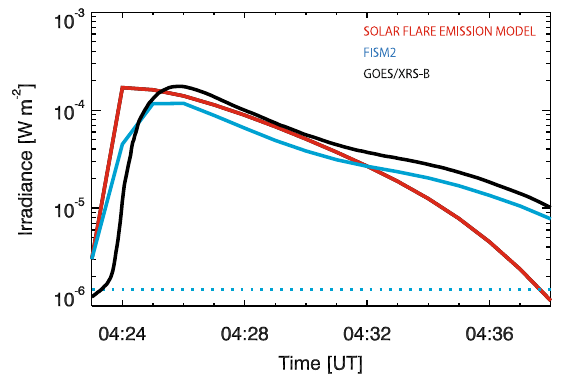
Fig. 1 Example of the observed and modeled soft X-ray fluxes of GOES/XRS-B. The soft X-ray fluxes of GOES/XRS-B during the X1.1-class flare on November 8, 2013. The solid red, blue, and black lines indicate the light curves obtained from the SFEM, the flare component of FISM2 (FISM2 flare), and the GOES/XRS observation, respectively. The dotted blue line indicates the daily component of FISM2 (FISM2 daily)